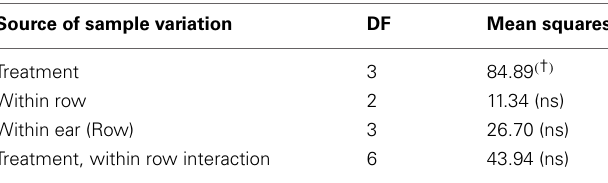
Table 1 | Sources of variation for kernel iron concentration in inbred genotype B73 field samples.